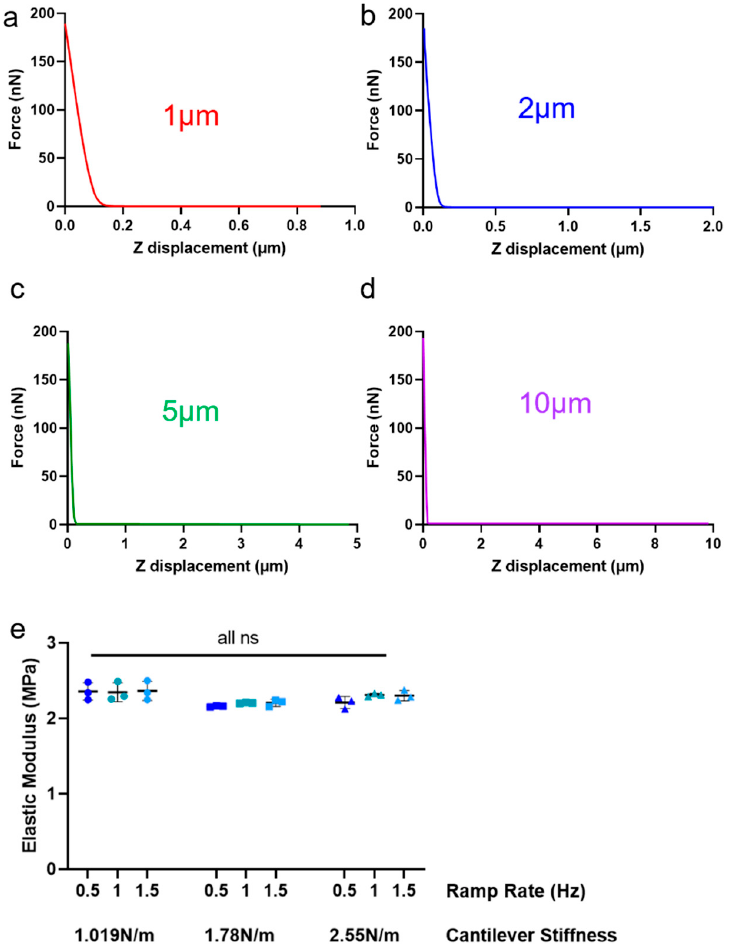
Figure 5. Effect of ramp size and rate on the measured elastic modulus of a PDMS gel, with a listed modulus of 2.5 MPa. ( a – d ) Examples of indentation curves created by four ramp sizes between 1 and 10 µm. Higher ramp sizes steepen the curve and decrease data resolution due to the large flat region preceding the useful curve. ( e ) The effect of three ramp rates on elastic moduli was determined with three different probes with cantilever stiffnesses of k = 1.78, 2.55, and 1.02 N/m. One-way ANOVA was performed and showed no significant changes with ramp rate. All indentations performed with ramp size = 2 µ m and indentation force 75% of maximum (~250 nN). ns = non-significant ( p > 0.05). Colors indicate different ramp rates; shape indicates different cantilever probes.